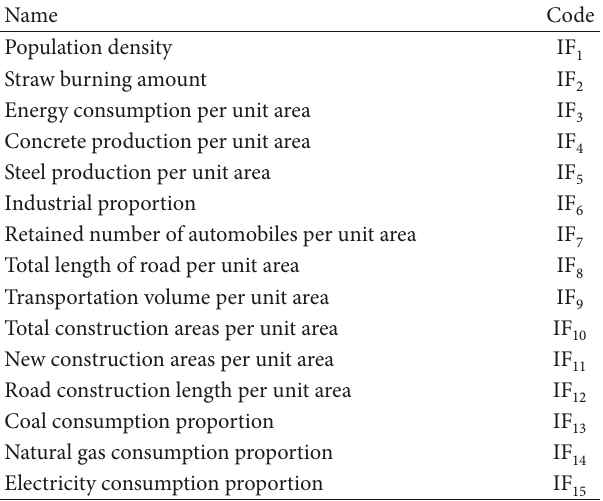
Table 4: The codes of the fifteen initial influential